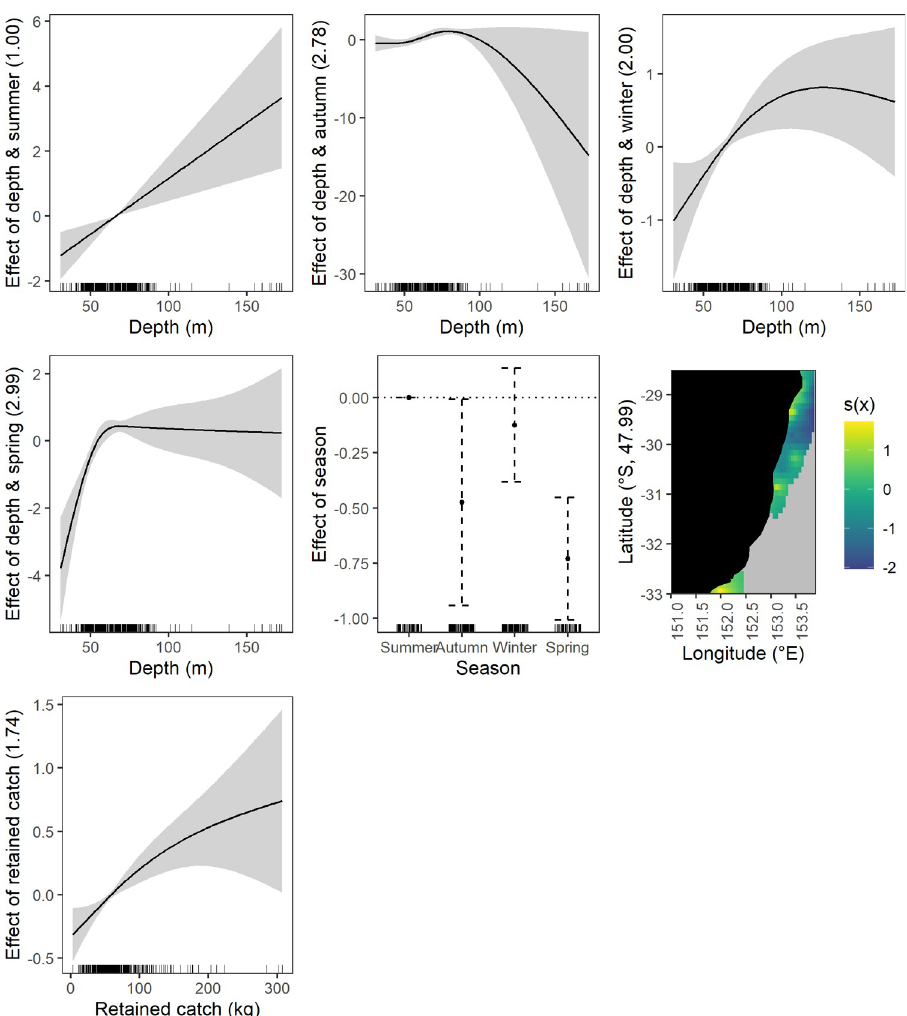
Fig 3. Significant effects plots from the discarded crustacean response generalised additive mixed models, shaded area represents the 95% confidence limits whilst the surfaces represent the effect of 2-d smoothing on spatial